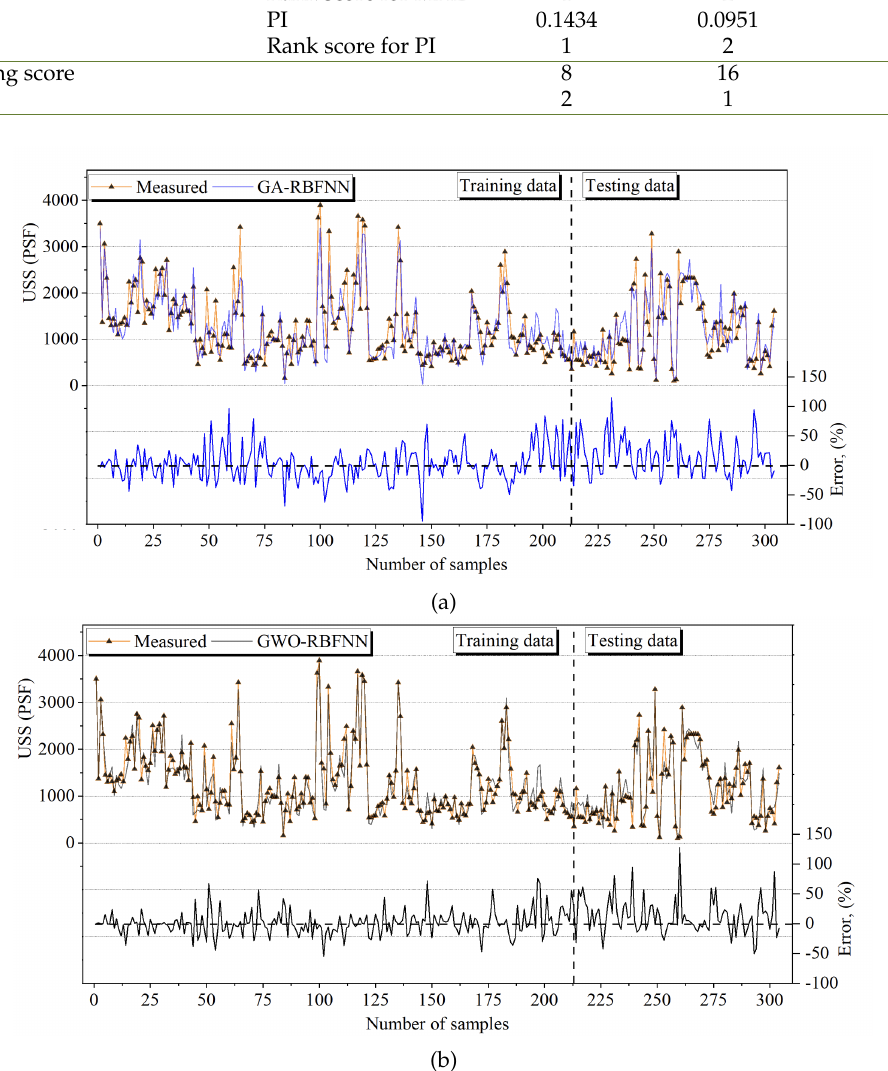
Fig. 8. USS prediction using models for a) GA-RBFNN; b)